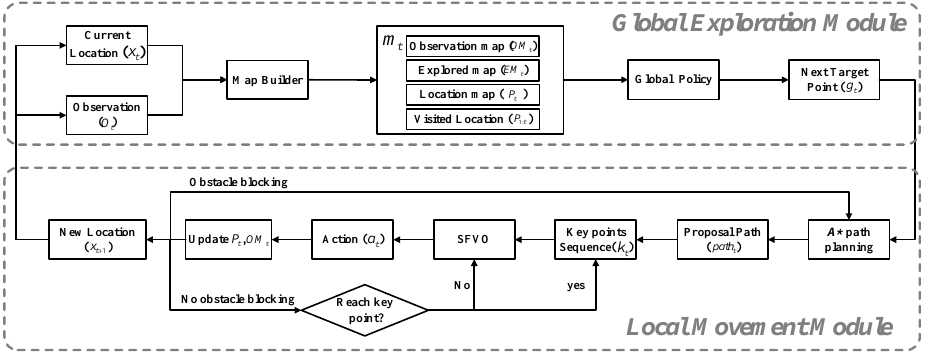
Figure 2. The overview of our IRHE-SFVO. In Global Exploration Module (GEM), the agent uses the current location and observation to build a spatial map m t , then input m t into Global Policy and output the next target point that will be explored. The Local Movement Module (LMM) determines the specific action to reach the target point quickly and safely based on the agent’s current location, the next target point, and the obstacle map maintained by the